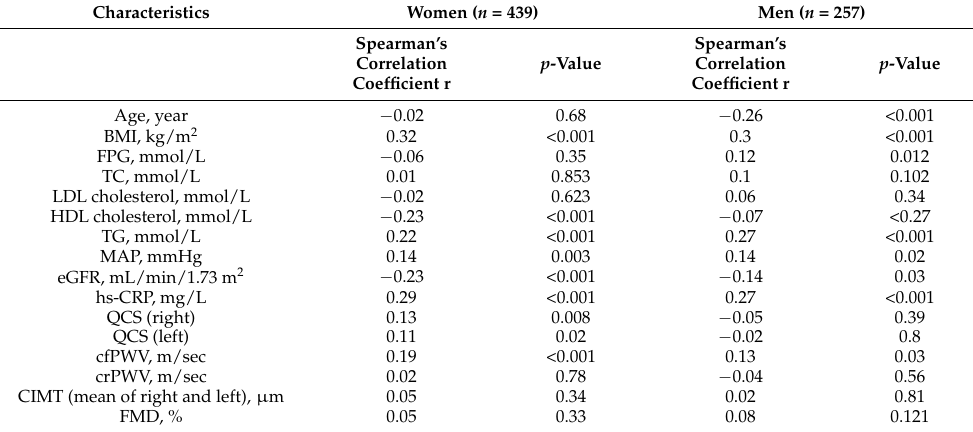
Table 5. The correlation between objective data, vascular parameters and SUA by sex.